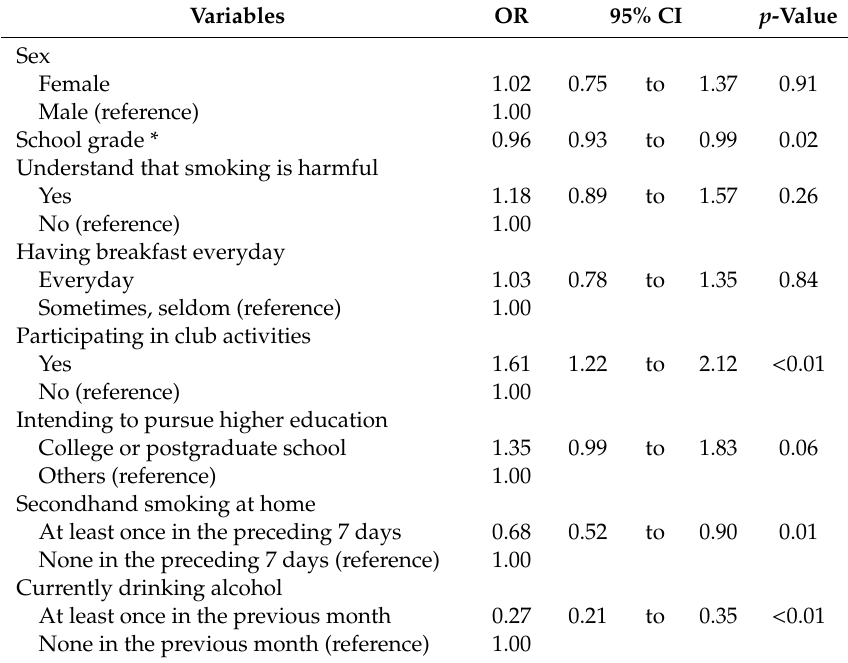
Table 5. The risk of exclusive alternative product use compared with any conventional cigarette use among any product users ( n =